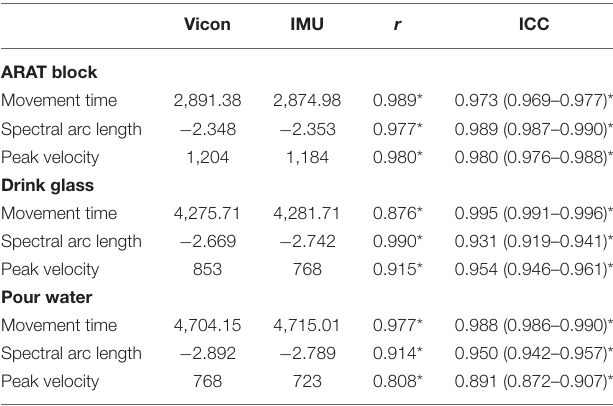
TABLE 1 | Mean movement time, spectral arc length, and peak velocity values for the outREACH sensor and Vicon, with associated correlations and intraclass correlations between the two devices.